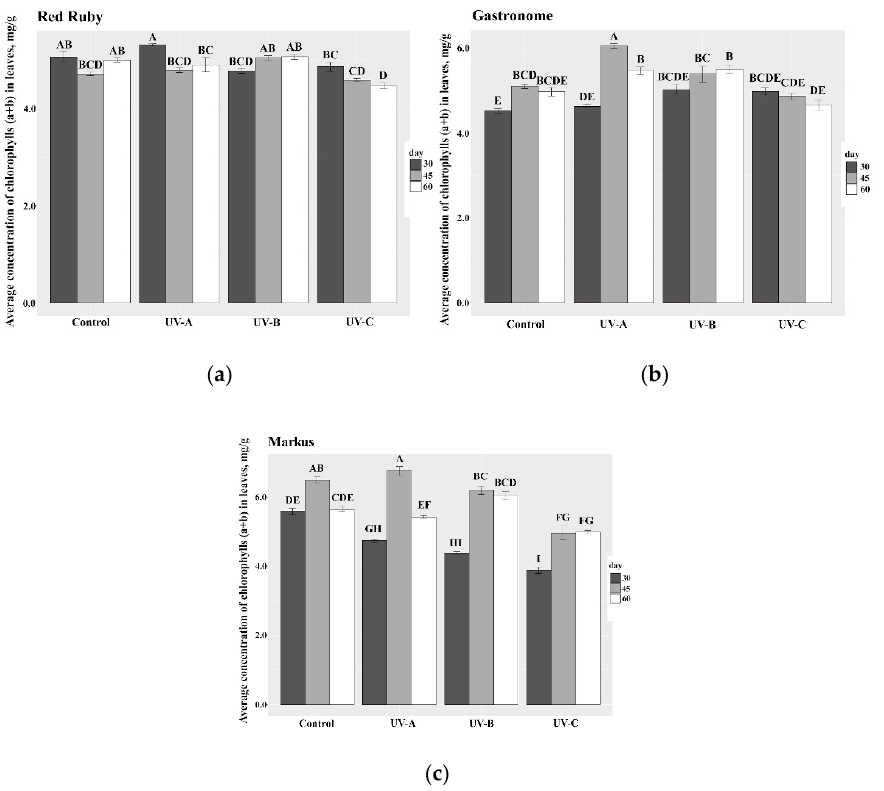
Figure 2. Average concentration of chlorophylls (a+b) in leaves, mg/g. Obtained on 30th, 45th and 60th days of cultivation of following basil varieties: “Red Ruby” ( a ), “Gastronome” ( b ) and “Markus” ( c ).